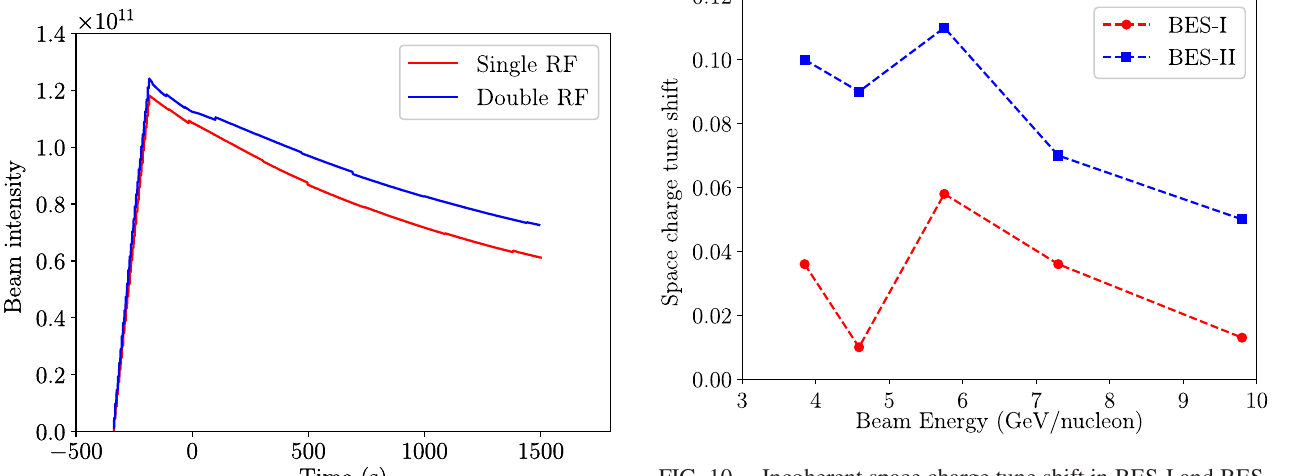
FIG. 10. Incoherent space charge tune shift in BES-I and BES- II at various beam energies. The lines connecting the data points are for the purpose of guiding the viewer ’ s eye and have no physical meaning.